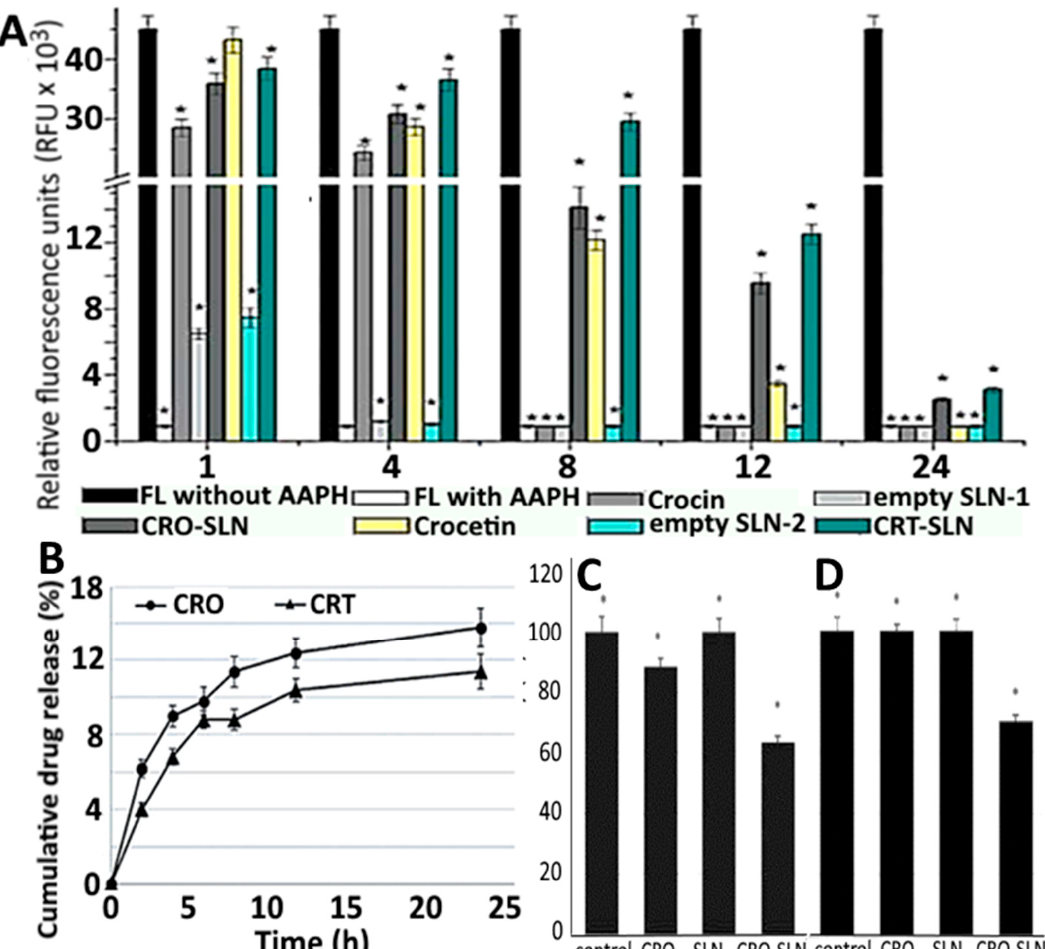
Figure 12. Oxygen radical absorbance capacity for free crocin and free crocetin as well as blank, crocin and crocetin solid lipid nanoparticles as measured by relative fluorescence units ( A ) along with cumulative crocin and crocetin release in phosphate buffered solution ( B ) and cell viability towards the human melanoma A375 cells ( C ) and malignant Schwann sNF96.2 cells ( D ). The results were expressed as mean ± standard deviation of ≥ 3 independent replicates and error bars represent the standard deviation from mean values. *, ** and *** above each bar indicating significantly different values. RFU = relative fluorescence unit, FL = fluorescein, AAPH = 2,2 ′ -azobis(2- amidinopropane) dihydrochloride, CRO = crocin and CRT = crocetin. Adapted with permission from Puglia, et al. [110].